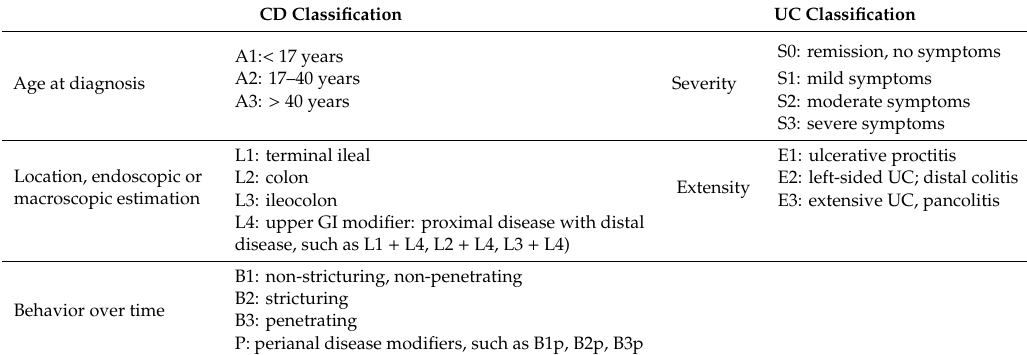
Table 1. The Montreal classification for Crohn’s disease (CD) and ulcerative colitis (UC) [9–11]. CD Classification UC